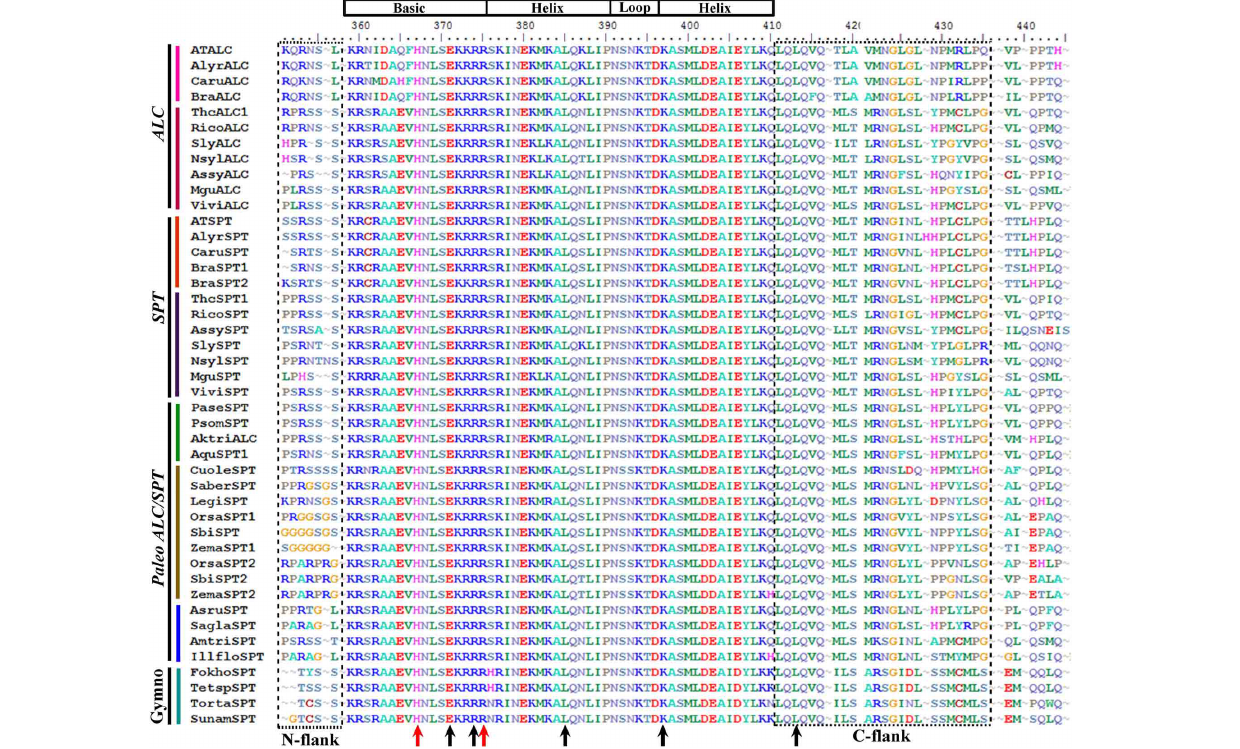
R16, L27, K39, L56, which are conserved in all bHLH plant and animal genes. E13 provides the SPT/ALC proteins with E-box binding (CANNTG) activity. The H9 and R17 positions (red arrows) show aminoacids that provide the SPT/ALC proteins with G-box (CACGTG) binding activity. The alignment also shows the conserved motif LQLQVQ in the C-flank of the bHLH motif followed by a fairly conserved motif MLS/TMRNGLSLH/N/PPL/MGLPG